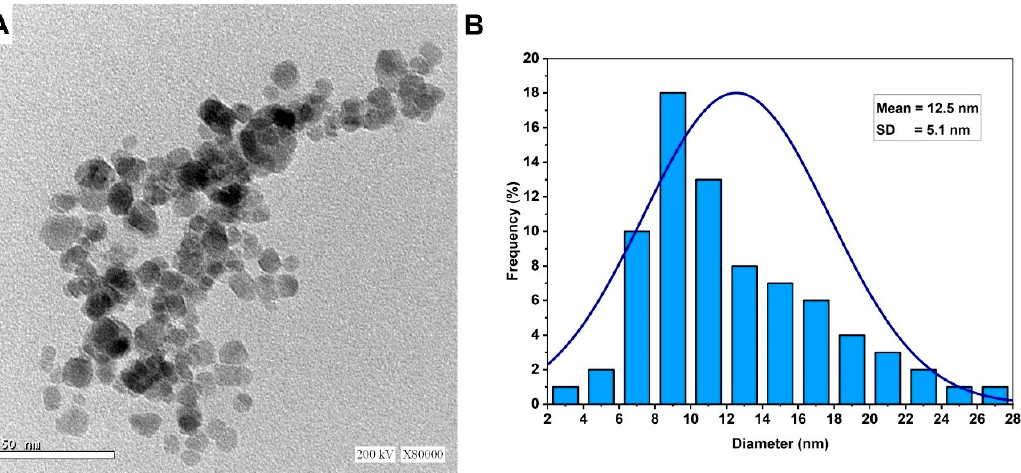
Figure 3. Characterization of Ag-NPs synthesized by A. flavus strain F5. ( A ) is the TEM image that showed a spherical shape and ( B ) is the size distribution according to the TEM image.